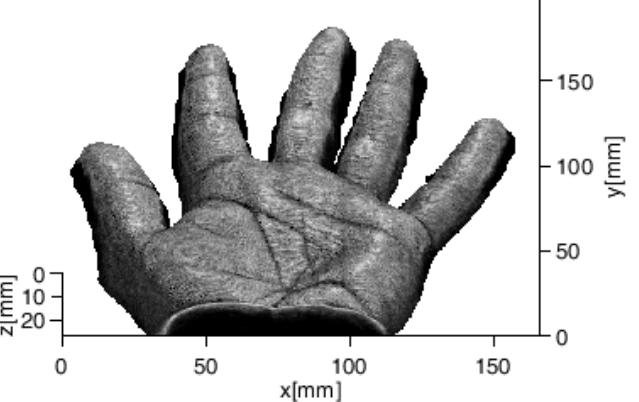
Figure 1. Example of 3D rendered human